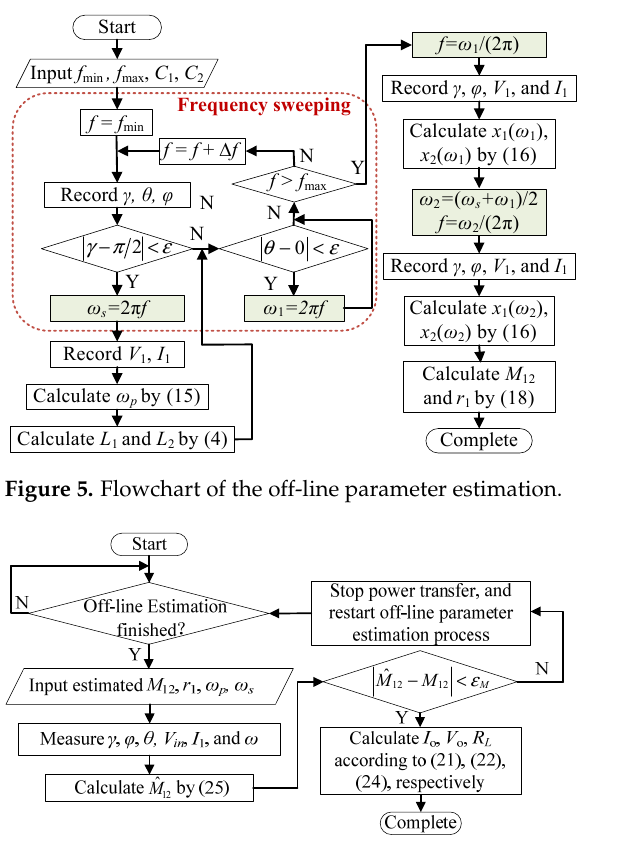
Figure 6. Flowchart of the online parameter estimation.